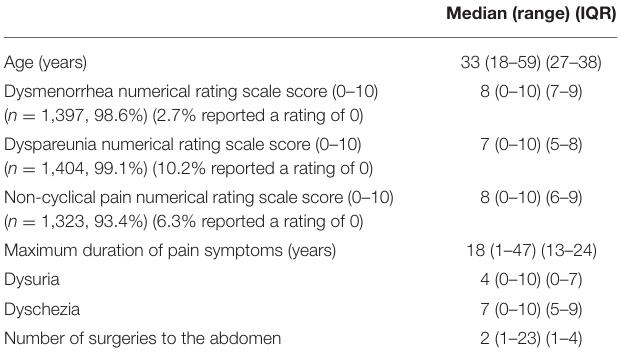
TABLE 1 | Demographics of participants.